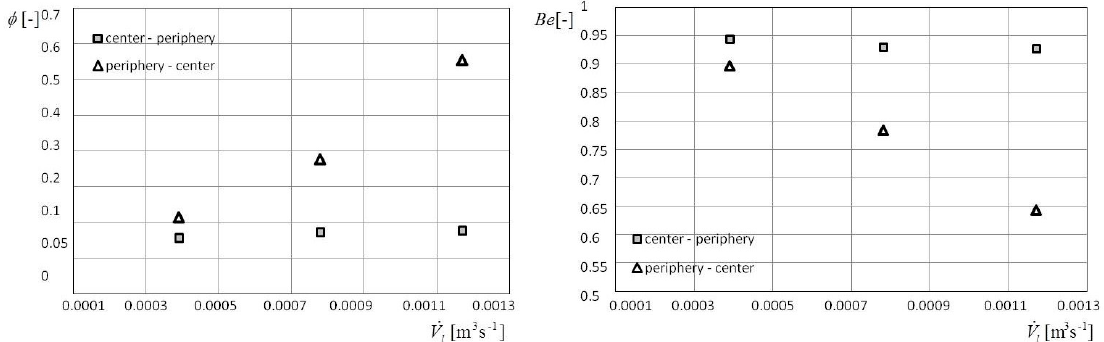
Figure 20. Experimental values of irreversibility distribution ratio and Bejan number for direct and counter impinging liquid